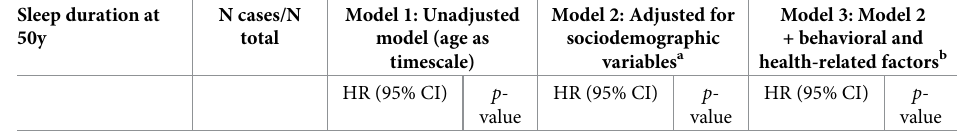
Table 3. Association of sleep duration at age 50 with transitions from a healthy state to first chronic disease, mul- timorbidity, and mortality ( N =